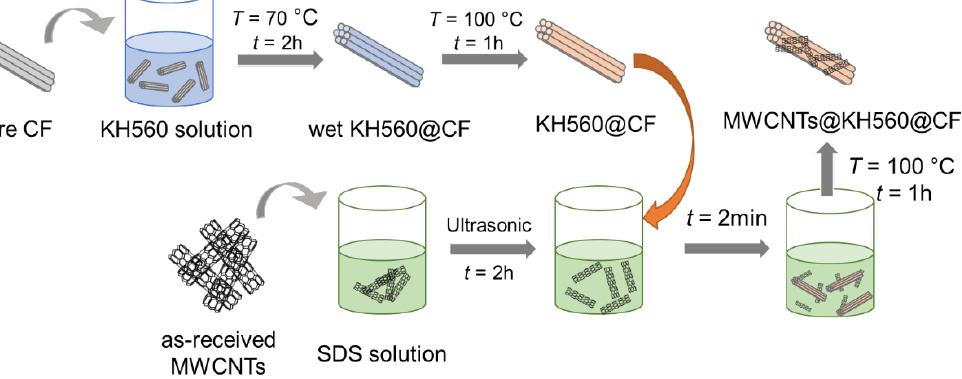
Figure 1. Schematics of the surface modification process on the carbon fiber